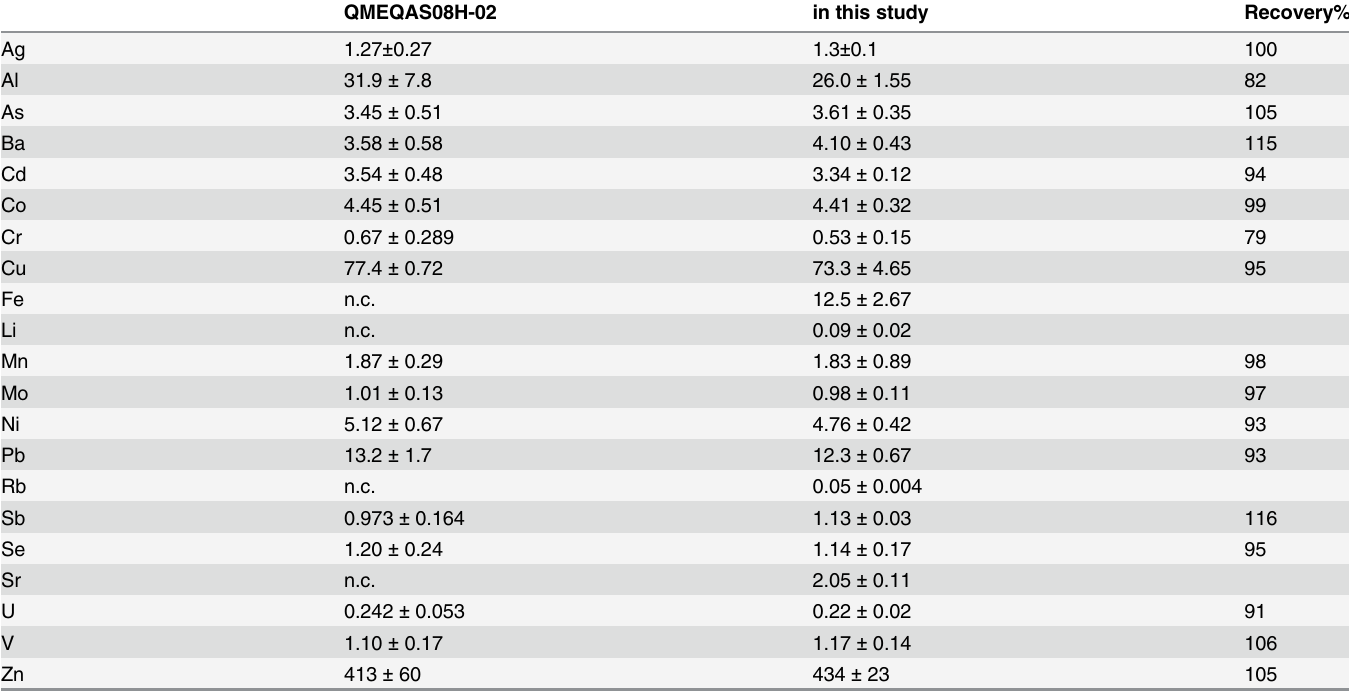
Table 2. Comparison of measured, reported concentrations and metal recovery of certified elements in standard reference material